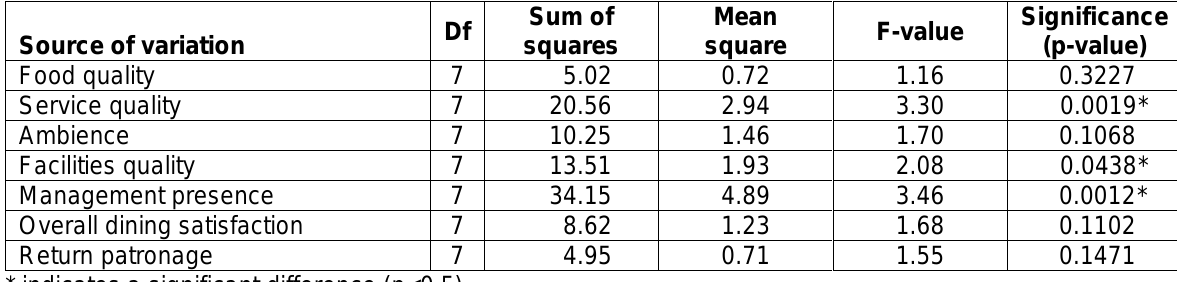
Sum of Mean Significance Df F-value squares square (p-value)